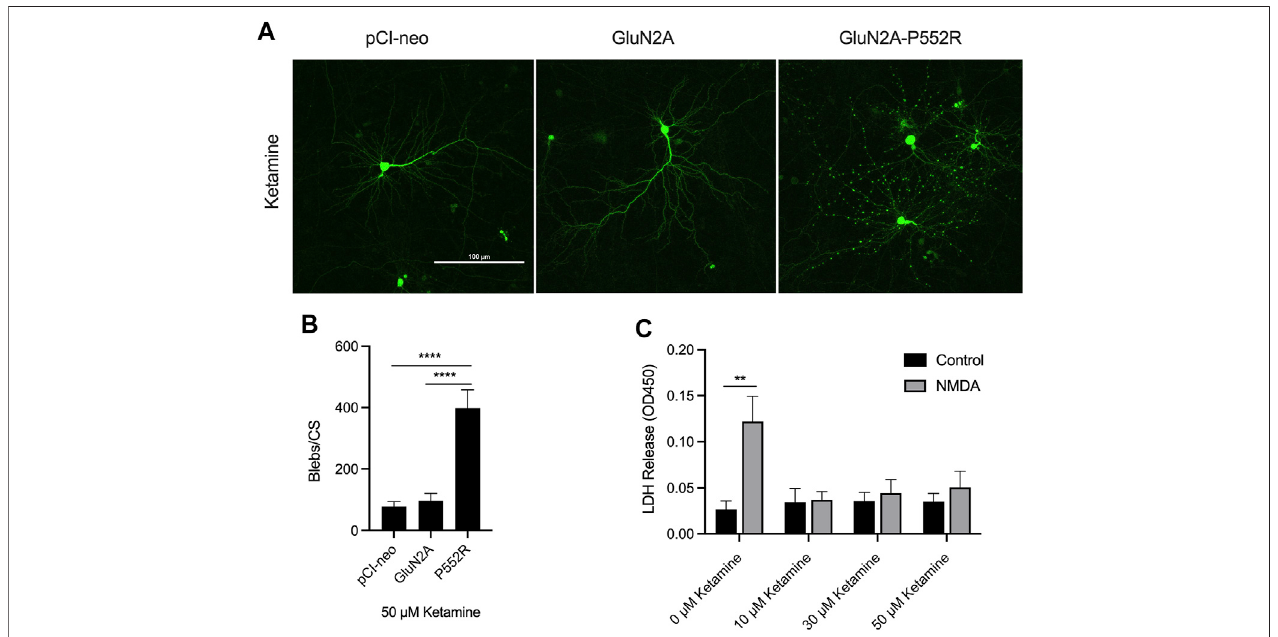
FIGURE 2 | Ketamine treatment does not rescue GluN2A-P552R-mediated dendritic blebbing. Representative images of cortical neurons transfected with GFP andeitherpCI-neo,GluN2A,orGluN2A-P552Randco-treatedwith50 µMketamineshowthatGluN2A-P552Rtransfectedneuronsexhibitpronouncedblebbingthatis not rescued by the open-channel blocker (A) . Quanti fi cation of dendritic blebbing con fi rmed signi fi cantly more blebs in the GluN2A-P552R group (B) (**** p < 0.0001, one-way ANOVA/Tukey post-hoc, n (cid:2) 9). LDH assays of untransfected primary cortical neurons treated with 10 µM glycine (control) or 10 µM glycine + 30 µM NMDA(NMDA)con fi rmedthatketamineisprotectiveagainstexcitotoxicinjury (C) (** p < 0.01,two-way ANOVA/Sidakpost-hoc, n (cid:2) 3).Therefore,thefailureofketamine to rescue GluN2A-P552R dendrotoxicity is not due to inef fi cacy of the drug in our culture system. Data are expressed as mean ± SEM from three independent experiments. Three transfections per condition were analyzed from each independent imaging